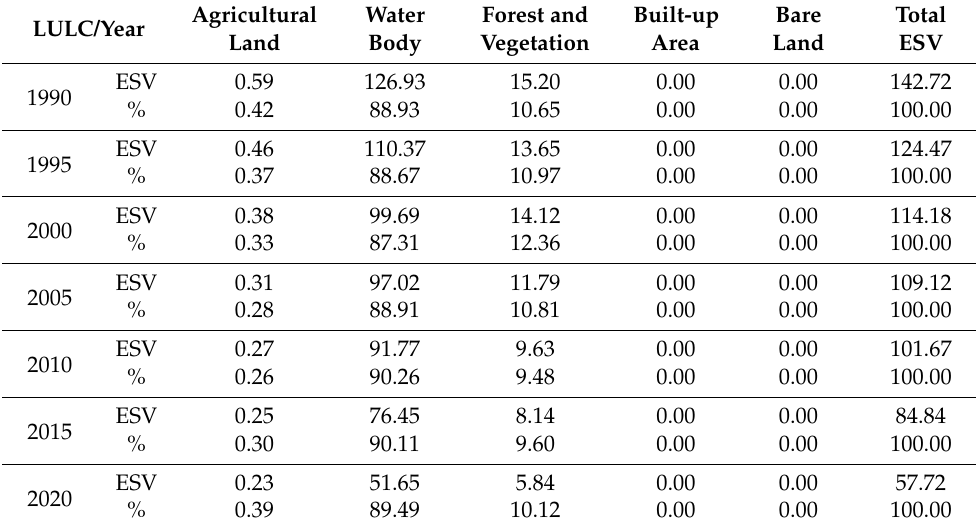
Table 7. Individual ESV by LULC and year. LULC/Year